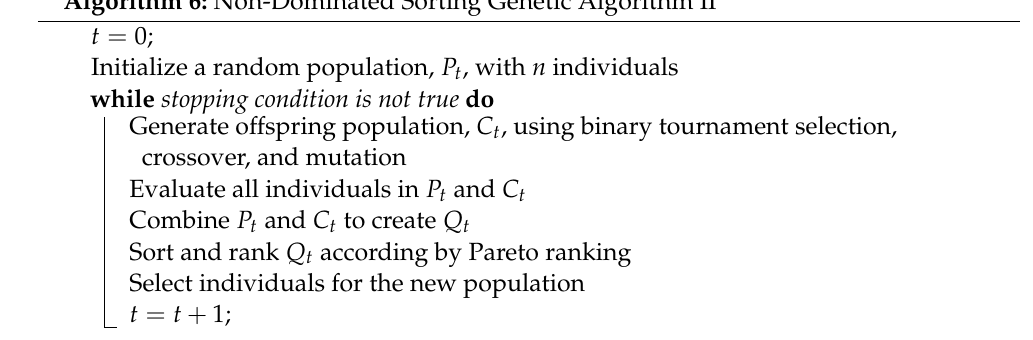
Algorithm 6: Non-Dominated Sorting Genetic Algorithm